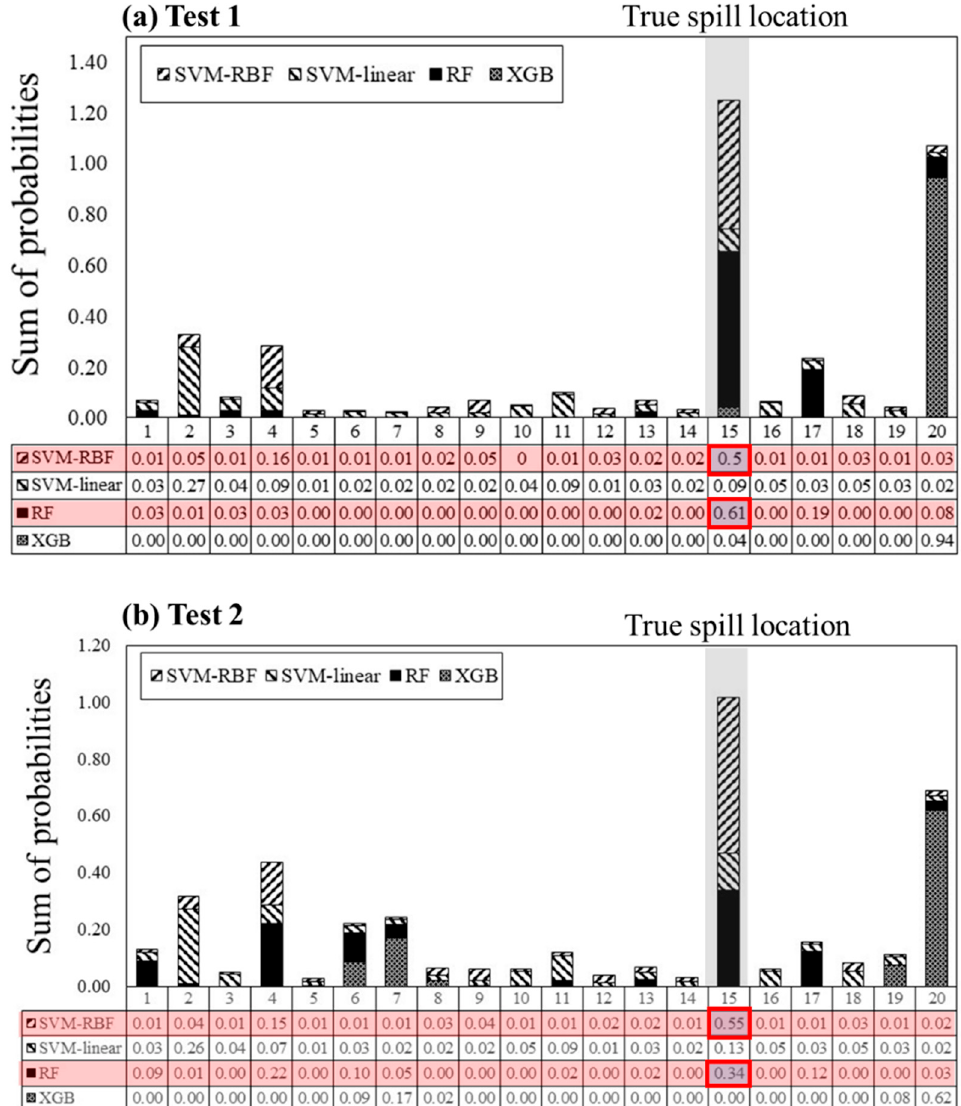
Figure 9. Predicted probability of spill location by using ML models using the measured BTC at the monitoring point (Gampo Bridge); The red boxes show the two highest values.